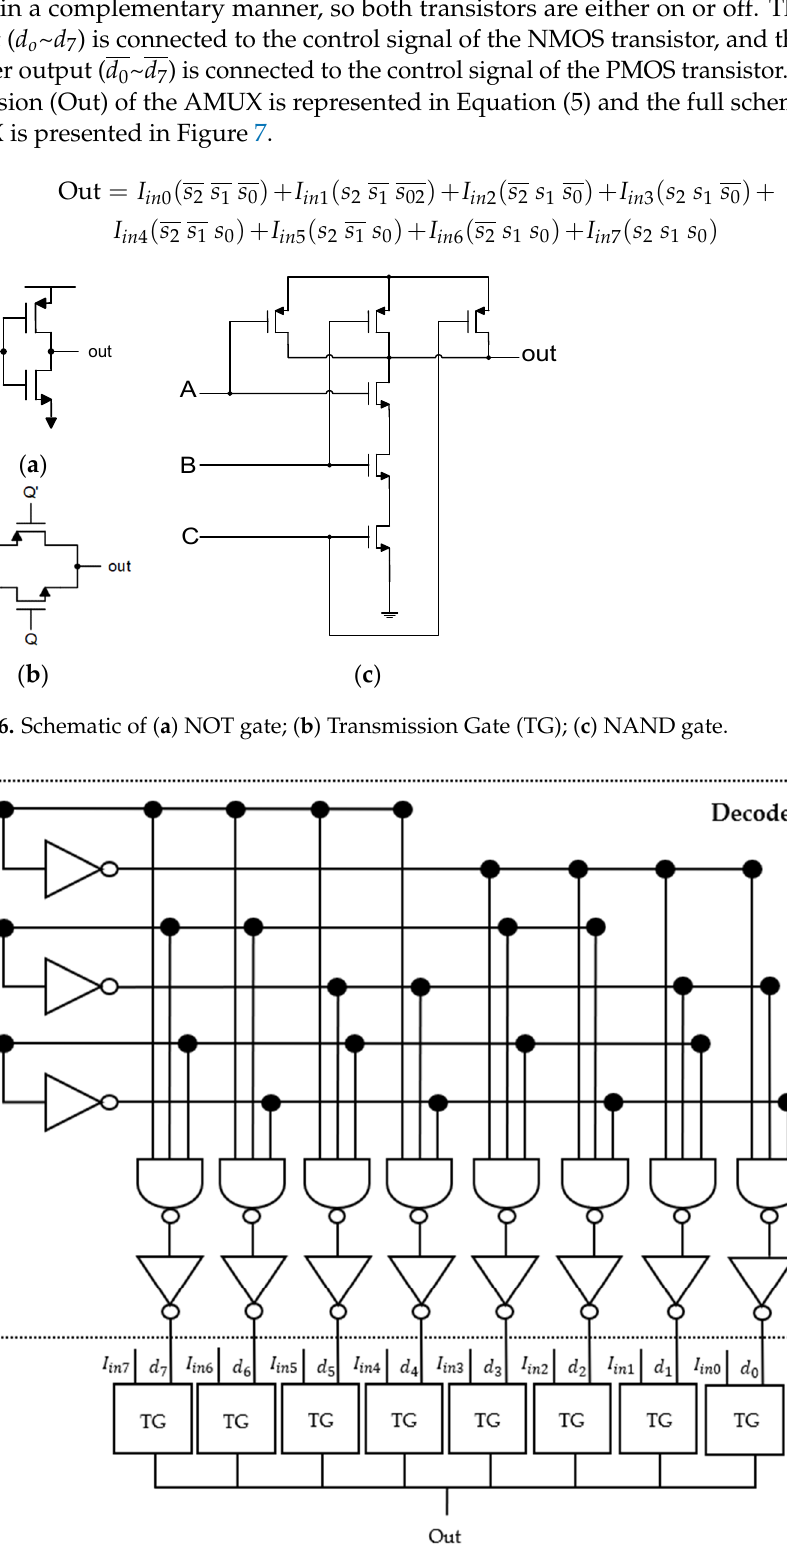
Figure 7. Schematic of an analog multiplexer (AMUX).